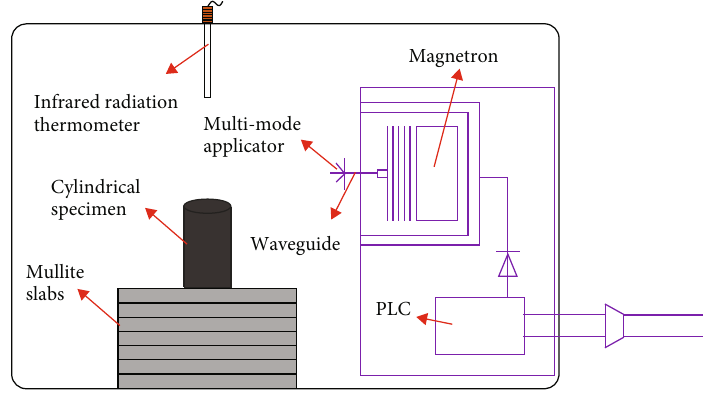
Figure 3: Schematic of microwave irradiation system. Table 2: Testing results of ultrasonic wave velocity induced by microwave